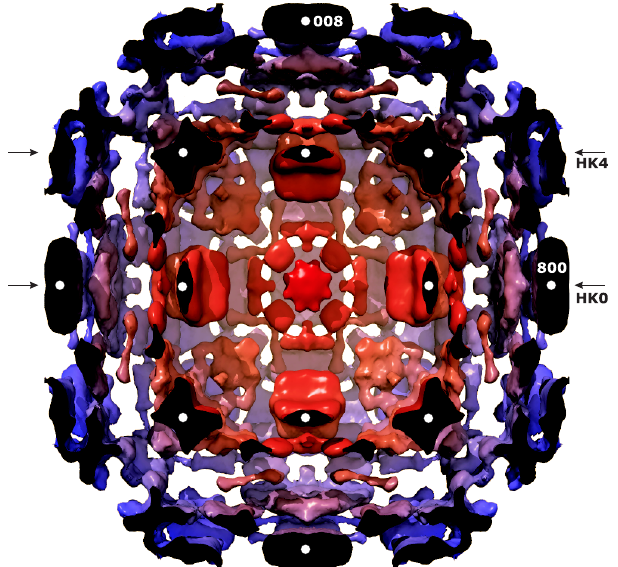
FIG. 1. Isosurface representation of diffuse scattering in mag- netite slightly above T . Color represents the distance to the V (000) node; diffuse clouds in the proximity of weak Bragg spots are removed. The half-space above the H0L plane is removed. j Q j -dependent intensity scaling is applied for the purpose of better visualization. White circles mark strong Bragg reflections in the H0L plane, and arrows denote HK0 and HK4 cuts perpendicular to the image